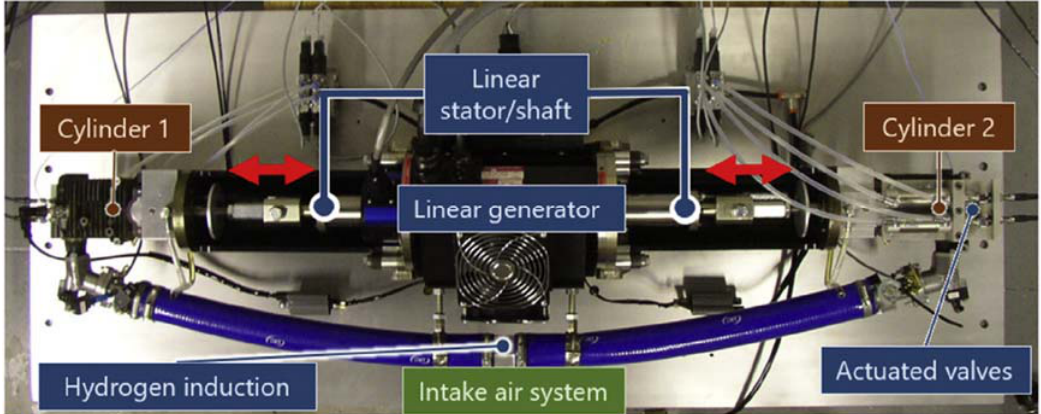
Figure 2. Actual FPEG prototype in Newcastle University [13].